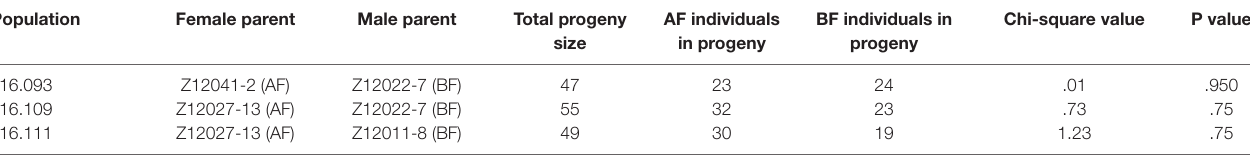
TABLE 3 | Summary of red raspberry ( R. idaeus ) populations segregating for the Annual-Fruiting (AF) trait.